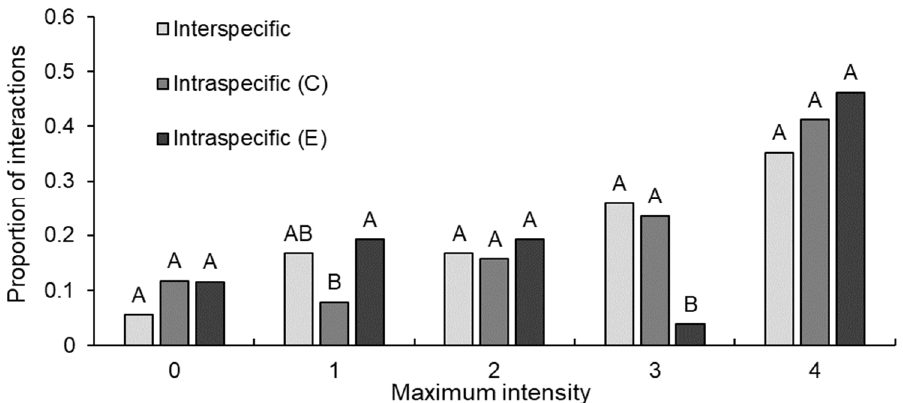
Figure 2. Proportion of interactions that reached each maximum intensity level for interspecific interactions between Euastacus dharawalus and Cherax destructor , intraspecific interactions between C. destructor (C) and intraspecific interaction between E. dharawalus (E). Different letters denote significant differences between the interaction types for each intensity level based on the Marascuilo procedure for multiple comparisons of